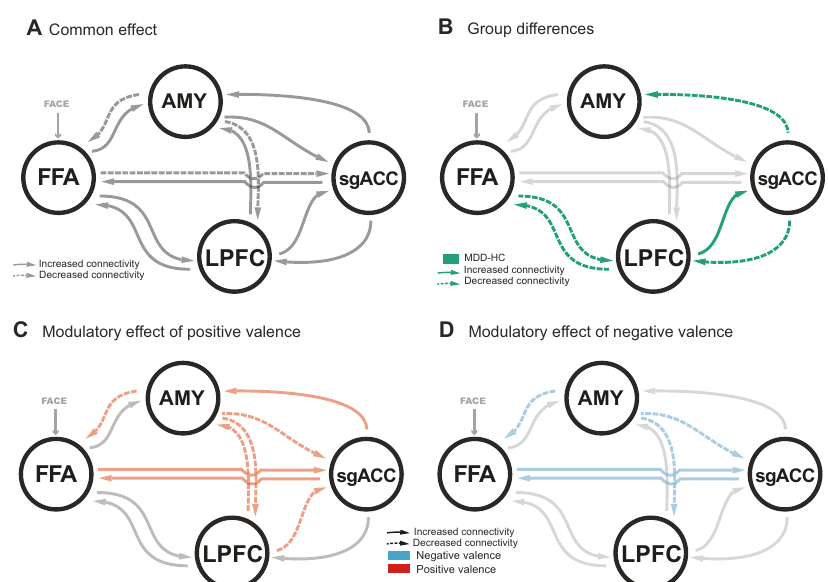
Fig. 4 DCM analysis of the prefrontal-amygdala network. A The common effect represents the overall model structure for the baseline (neutral faces) across all participants. B Group differences were primarily found in the bidirectional cortical pathway FFA-LPFC-sgACC for the average connectivity across conditions. In addition, connectivity between sgACC and the amygdala was decreased in patients. C , D Efferent connectivity from the amygdala was modulated by positive ( C ) and negative ( D ) valence. In addition, processing of positive valence was associated with altered LPFC — amygdala connectivity and the LPFC — sgACC — amygdala pathway. Detailed results are reported in Table S7. AMY amygdala, FFA fusiform face area, HC healthy controls, LPFC lateral prefrontal cortex, MDD major depressive disorder, sgACC subgenual anterior cingulate